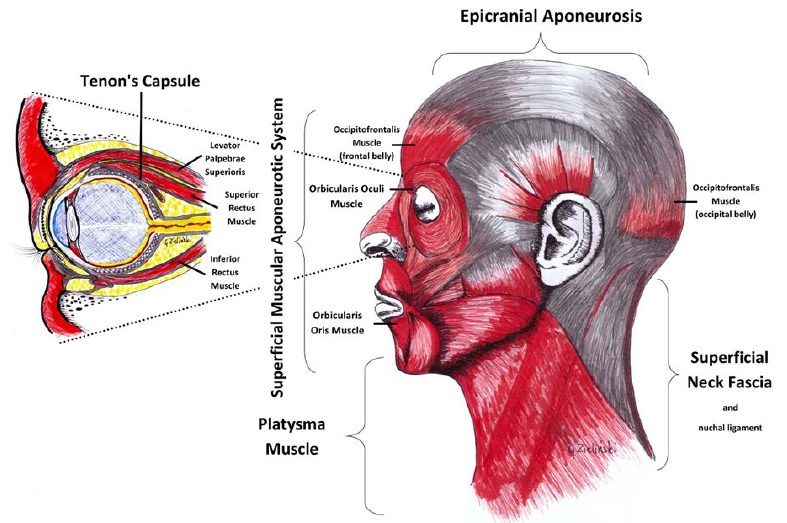
Figure 4. Scheme of anatomical